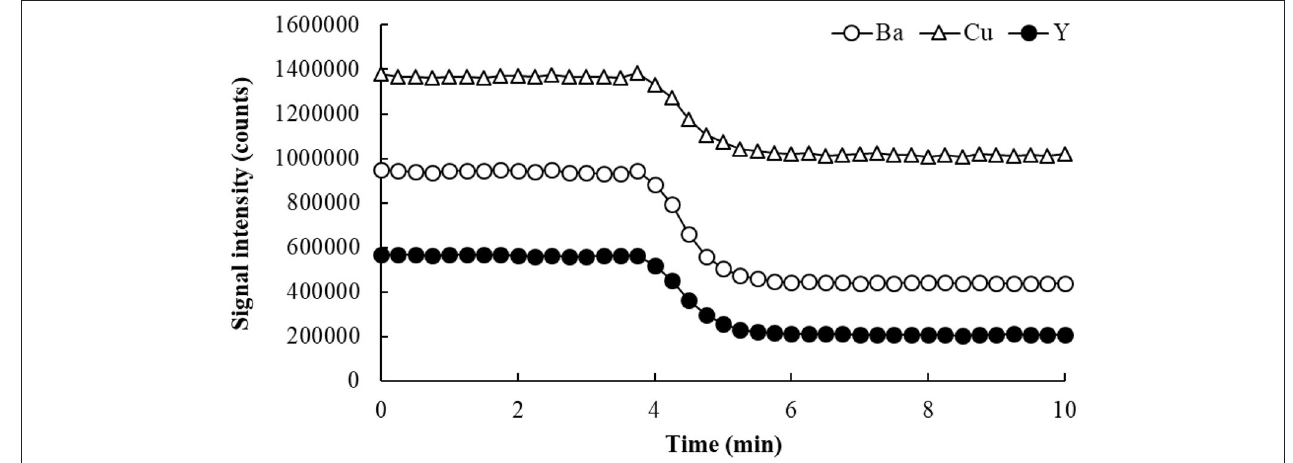
FIGURE 4 | SDA plot for the determination of Ba and Cu in Oyster Tissue (NIST 1566b) by ICP-MS. Yttrium was used as internal standard, and He flowing at 3.5 mL/min was used in the collision/reaction cell.